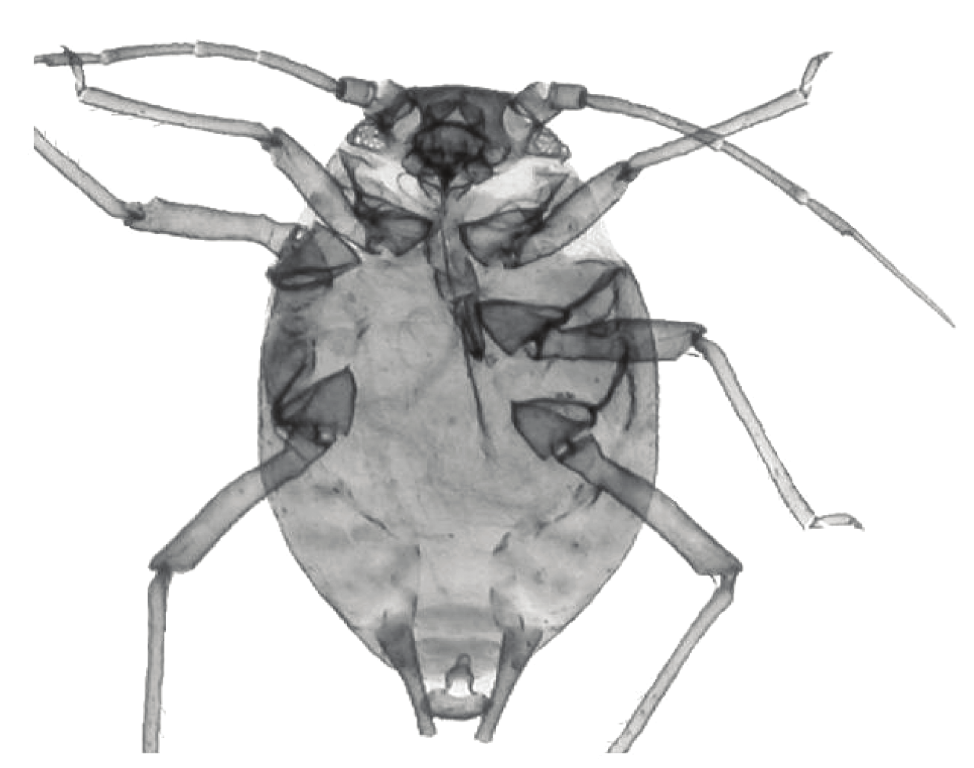
Fig. 12. Muscaphis musci börner, 1933. Aptera with siphunculus. (photo roger blackman, from blackman 2010, with license from the royal entomological